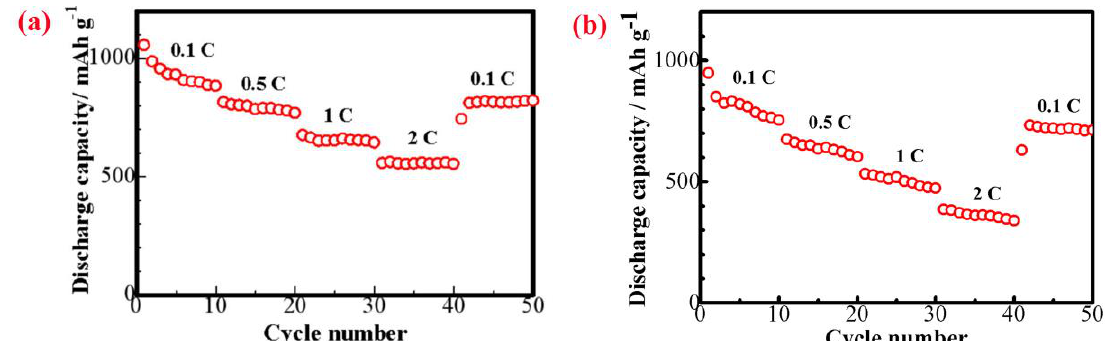
Figure 11. Rate performances of lithium – sulfur batteries with the ( a ) S/CeO 2 /RGO and ( b ) S/RGO cathodes at different current densities.